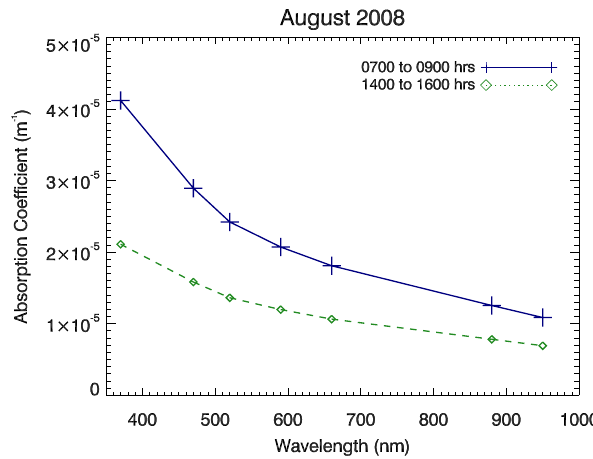
Fig. 5. Spectral characteristics of absorbing aerosols during morn- ing hours and afternoon